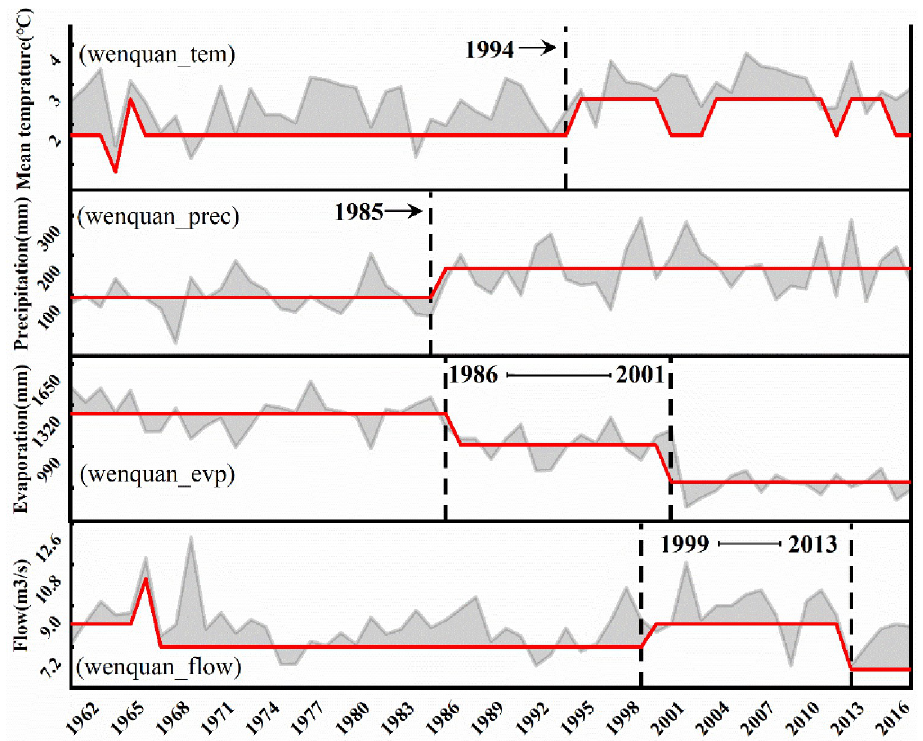
Fig 6. Temporal changes of hydroclimatic variables at Wenquan station ( p < 0.05). The gray line, red line, and gray area represent the runoff observation, breakpoint segmentation value, and coverage area, respectively.